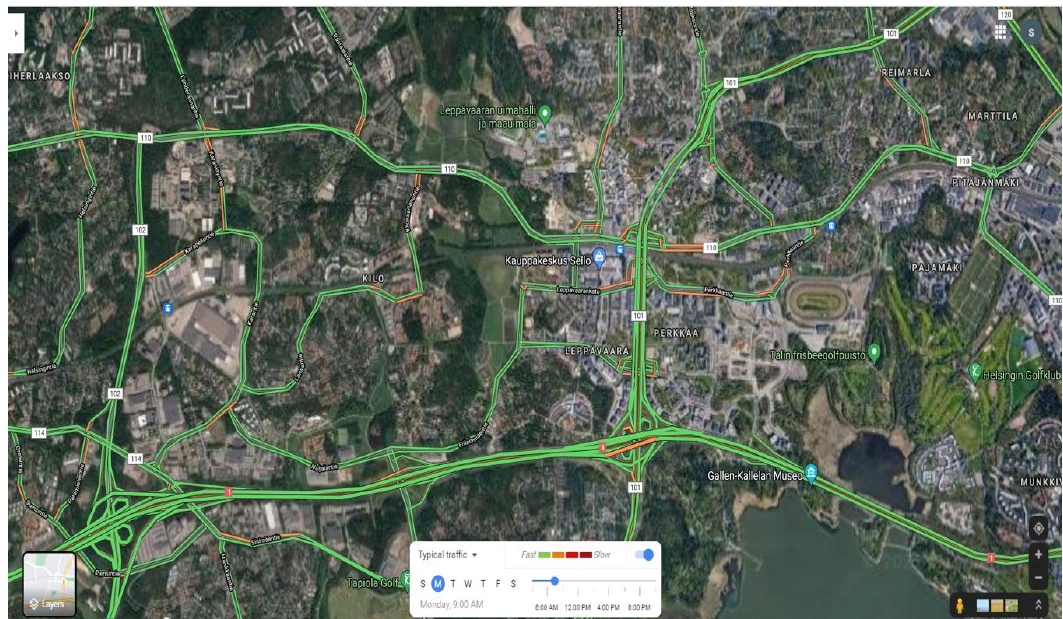
Figure 6. Congestion levels in Helsinki [113].